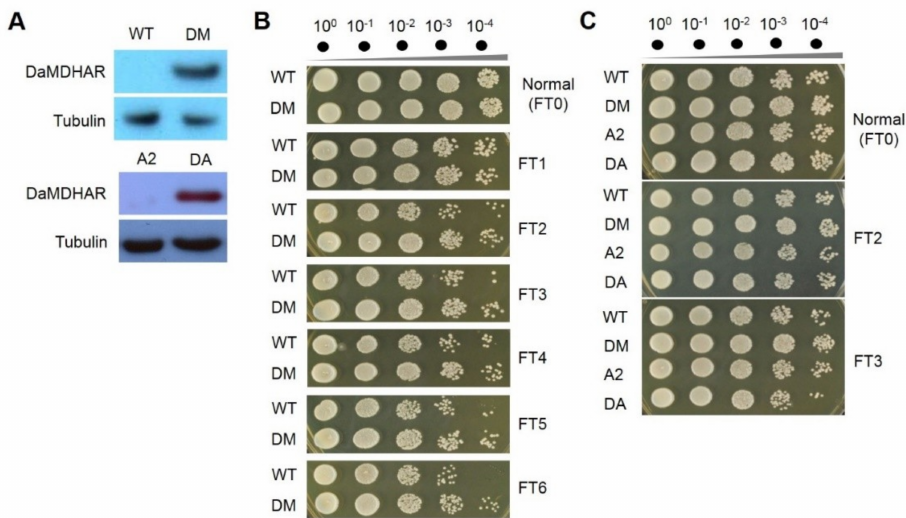
Figure 4. Stress response of DaMDHAR -expressing yeast during freezing and thawing (FT)